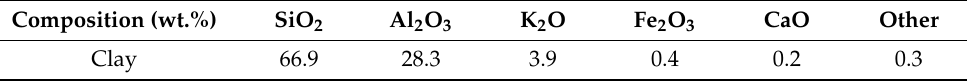
Table 1. Chemical composition of high white clay (X-ray fluorescence analysis). Composition